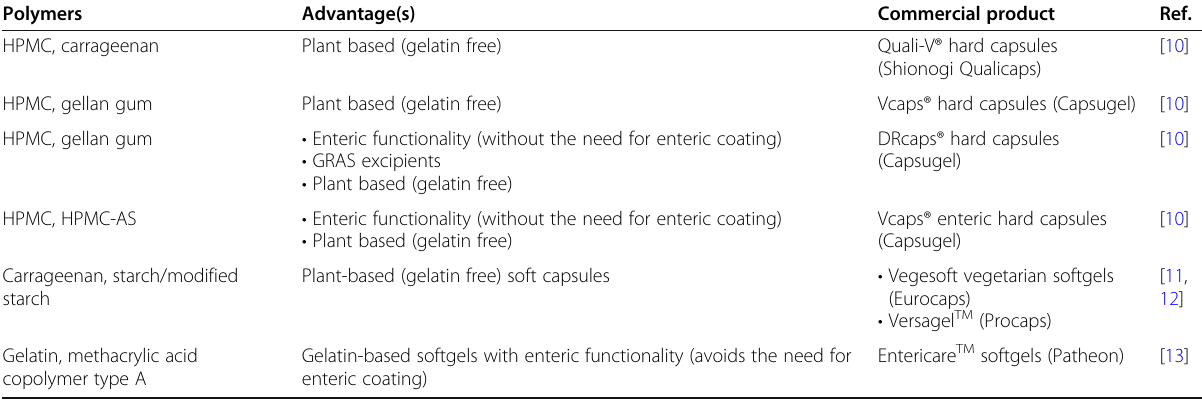
Table 4 Polymer blends used in capsules